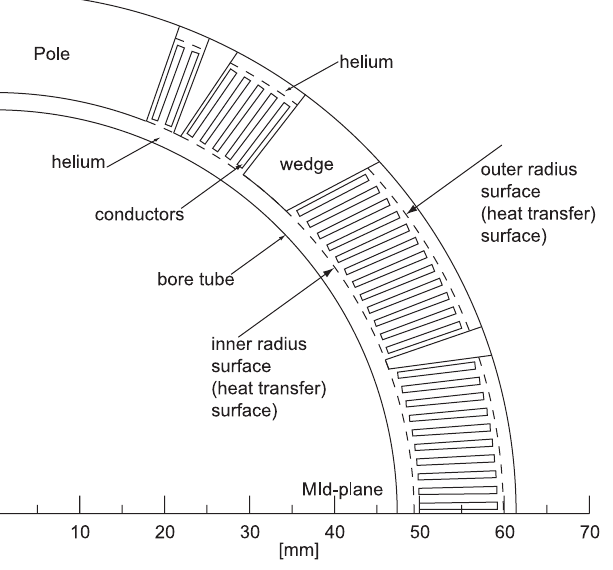
FIG. 15. Transverse cross section of cos (cid:1) coil (one